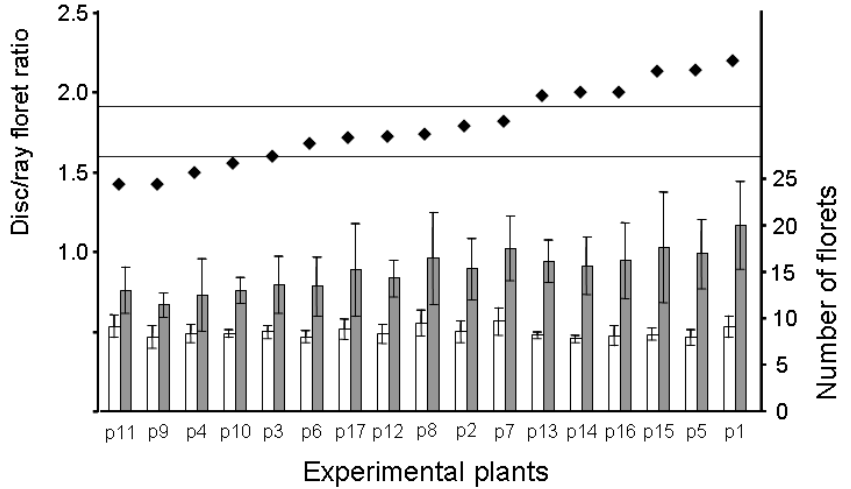
F IGURE 1. Variation in disc to ray florets ratio and number of floret types per inflorescence in the experimental Centaurea cyanus